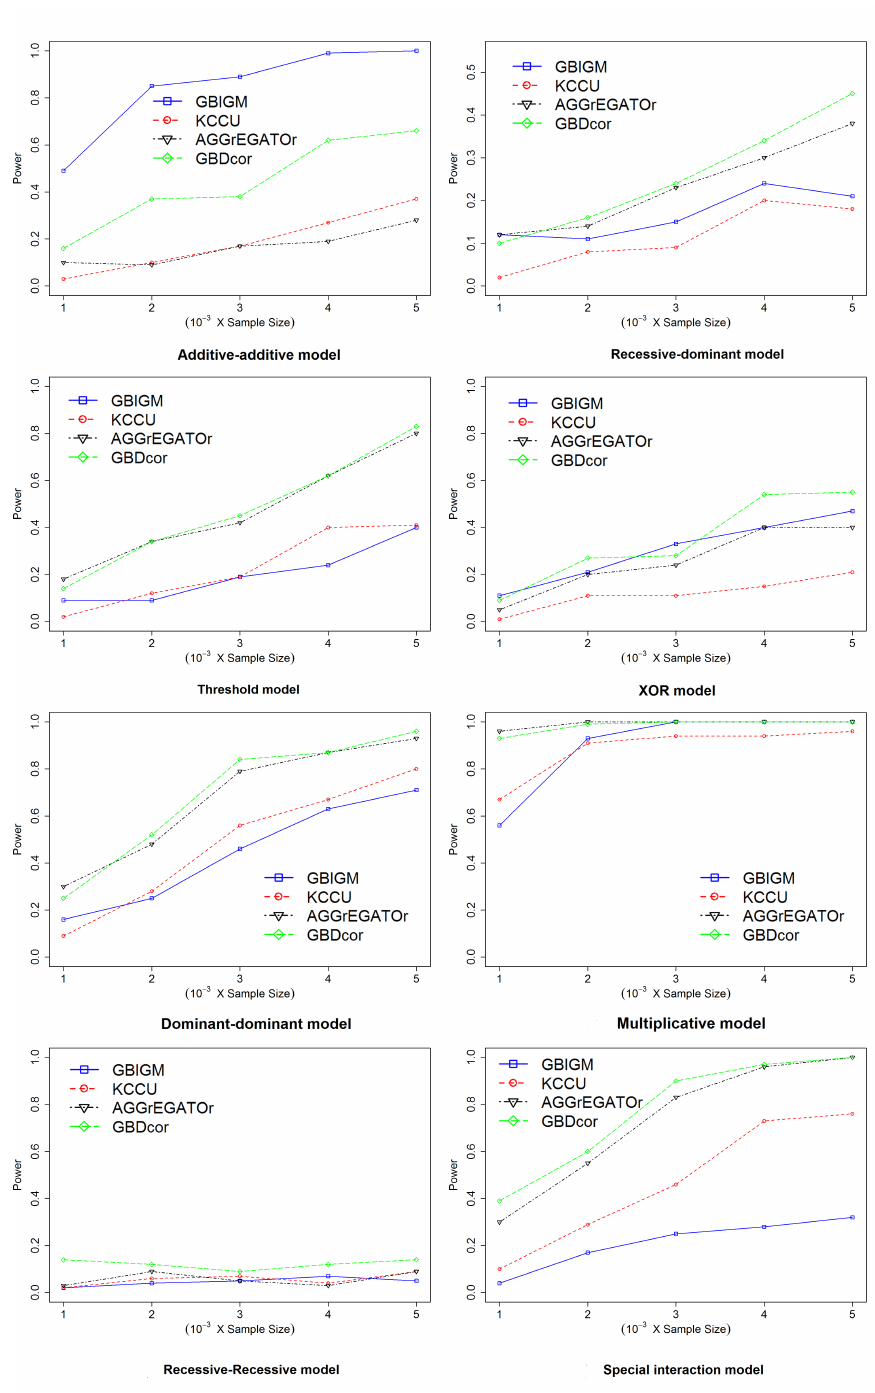
Figure 3. Empirical, simulation-based statistical power of GBIGM, KCCU, AGGrEGATOr, and GBDcor under eight disease models, after varying the n ∈ { 1 k ,2 k ,3 k ,4 k ,5 k } . GBDcor performed better than alternative methods for almost the entire range of settings that we used. The benefits of using distance correlation to learn the dependence relationship of two genes in cases and controls were pronounced in the gene–gene interaction detection scenario. For example, we were able to design a statistic to represent the degree of difference of the two distance correlation coefficients and to apply a permutation to find the empirical distribution of our designed